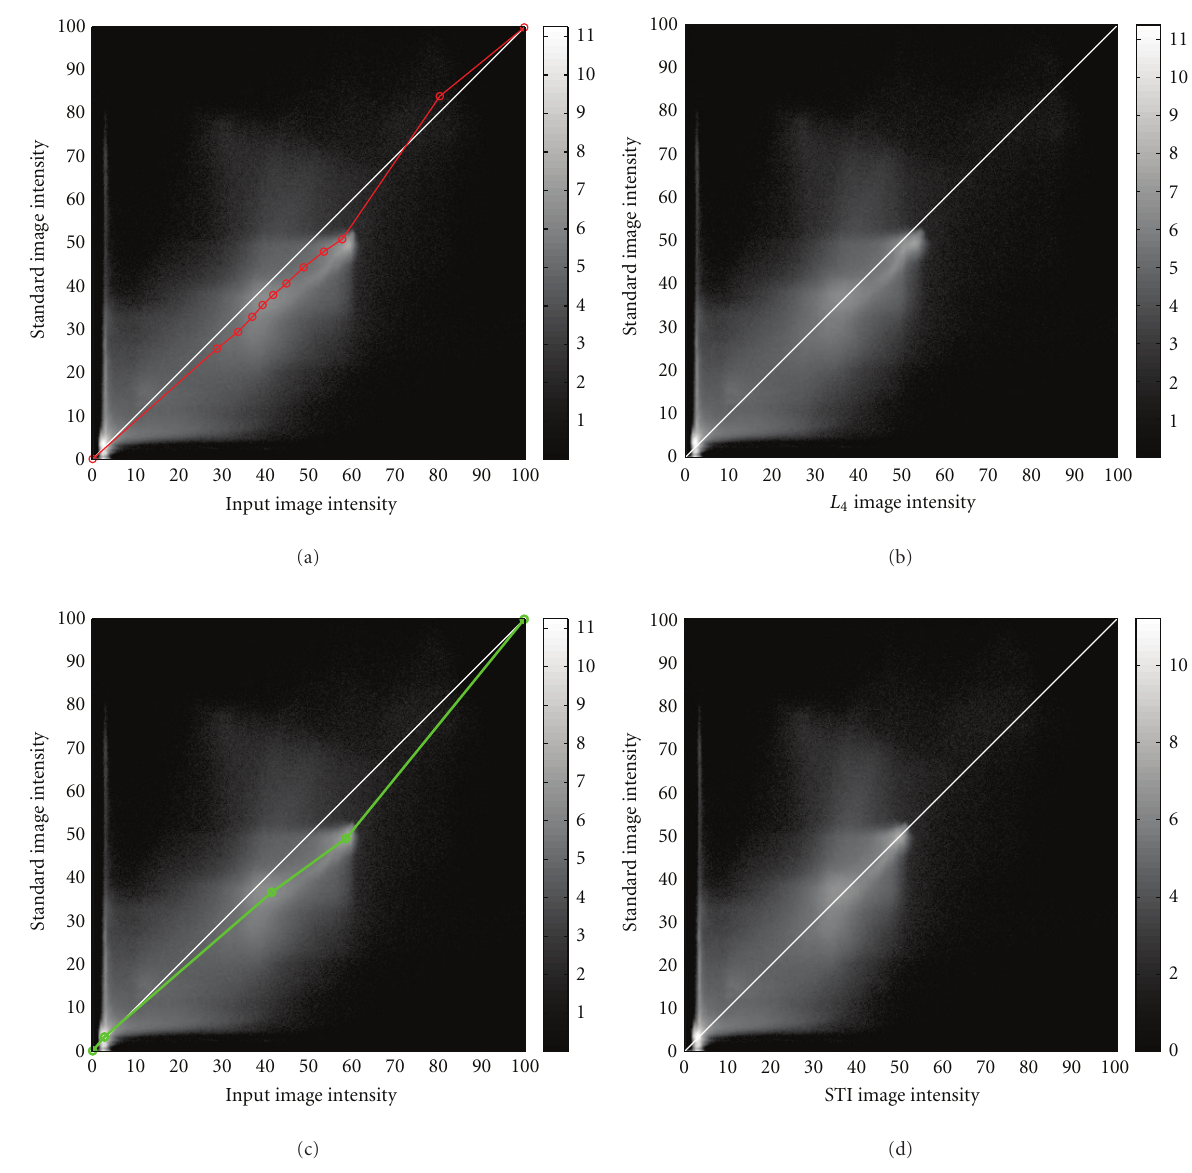
Figure 3: Natural logarithm of the joint intensity histograms obtained for Subject 1 at Site 1, whose images are presented in Figure 2, (a, c) before and (b, d) after standardization with (a, b) L 4 and (c, d) STI. In (a, c), we overlaid the intensity mapping functions obtained with L 4 (a) and STI (c). The histogram diagonals (white) represent perfect intensity